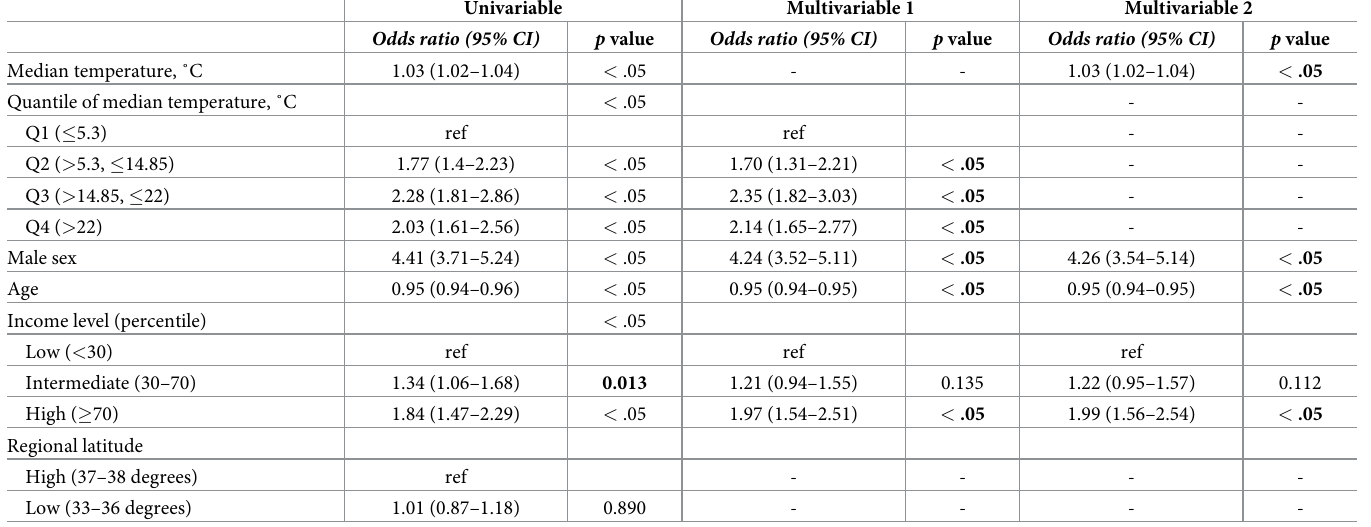
Table 4. Logistic regression analyses of factors associated with achilles tendon